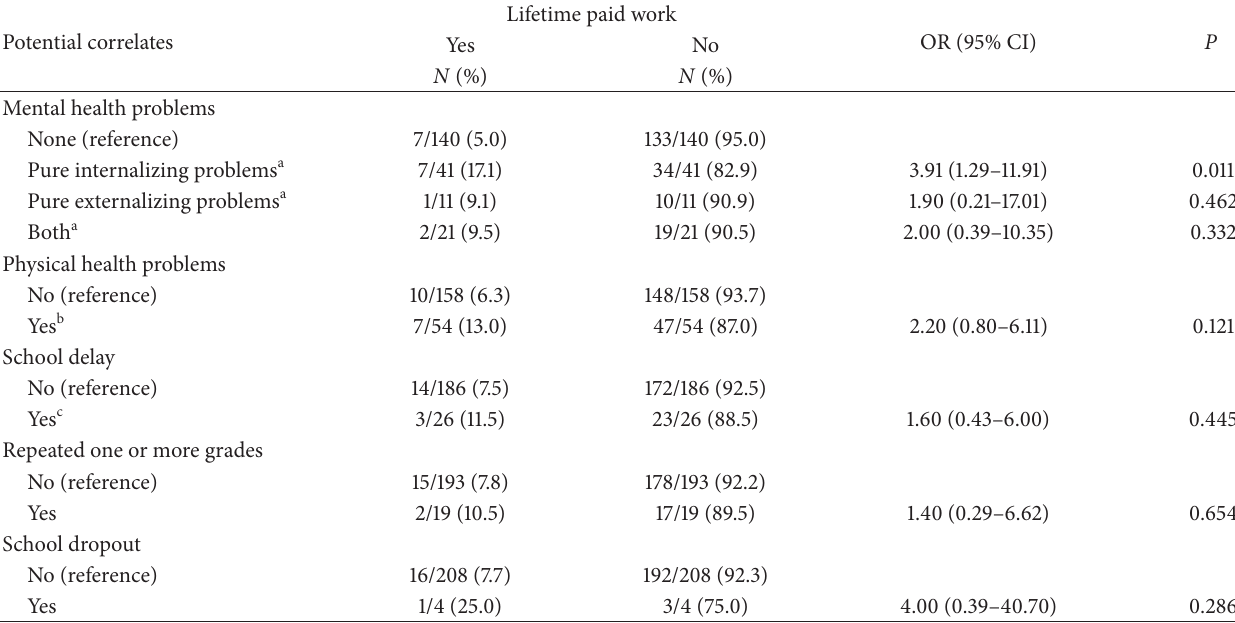
Table 2: Health and education potential correlates of lifetime paid work among children aged 9–13 years ( 𝑛 = 212 ) in Embu, S˜ao Paulo,